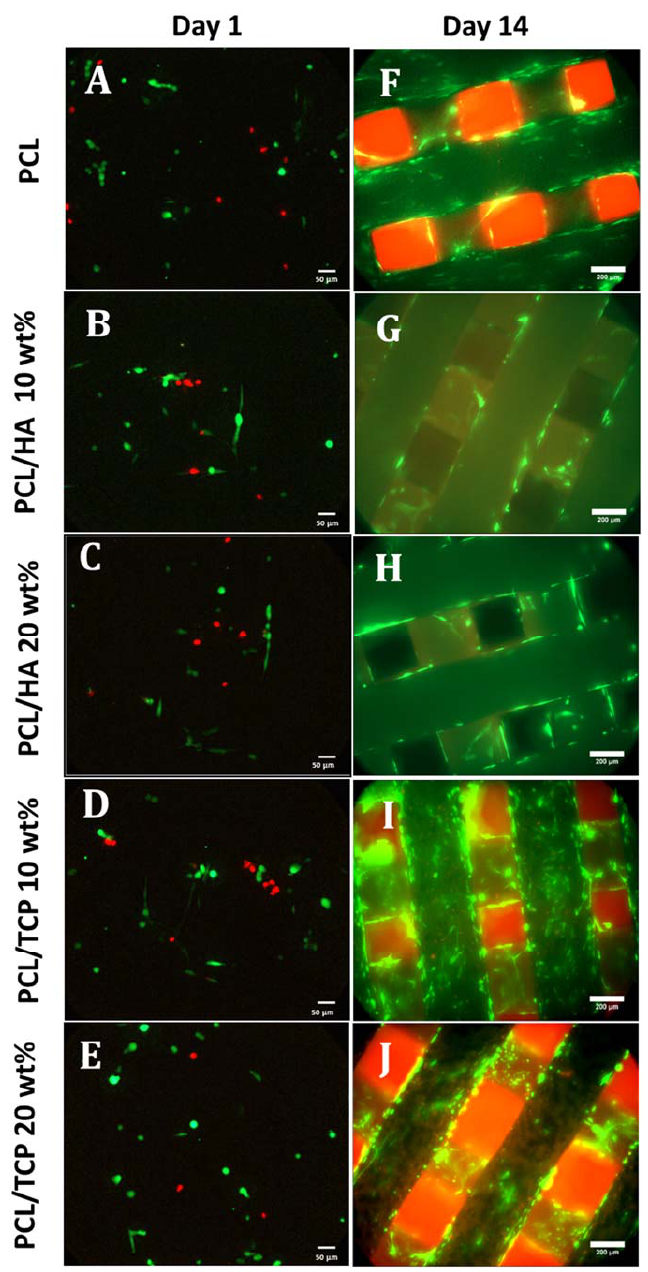
Figure 6 . Live (green) and dead (red) cells on PCL, PCL/HA 10 wt %, PCL/HA 20 wt %, PCL/TCP 10 wt %, and PCL/TCP 20 wt % at day 1 ( A – E , respectively, 20× magnification) and day 14 ( F – J , respectively, 10× magnification).